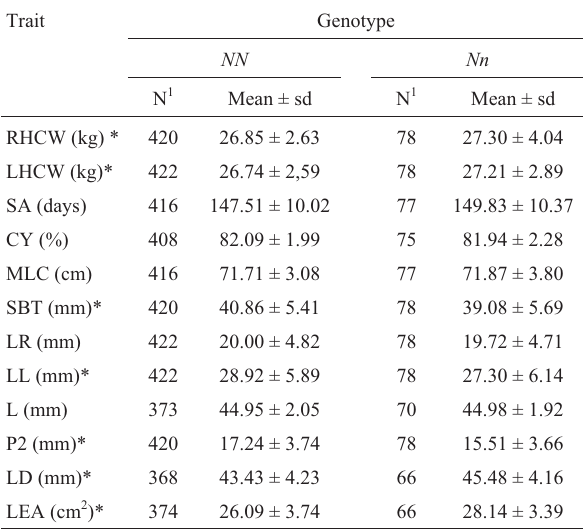
Table 1 - Carcass traits (means and standard deviations) obtained for each PSS genotype ( NN and Nn ).